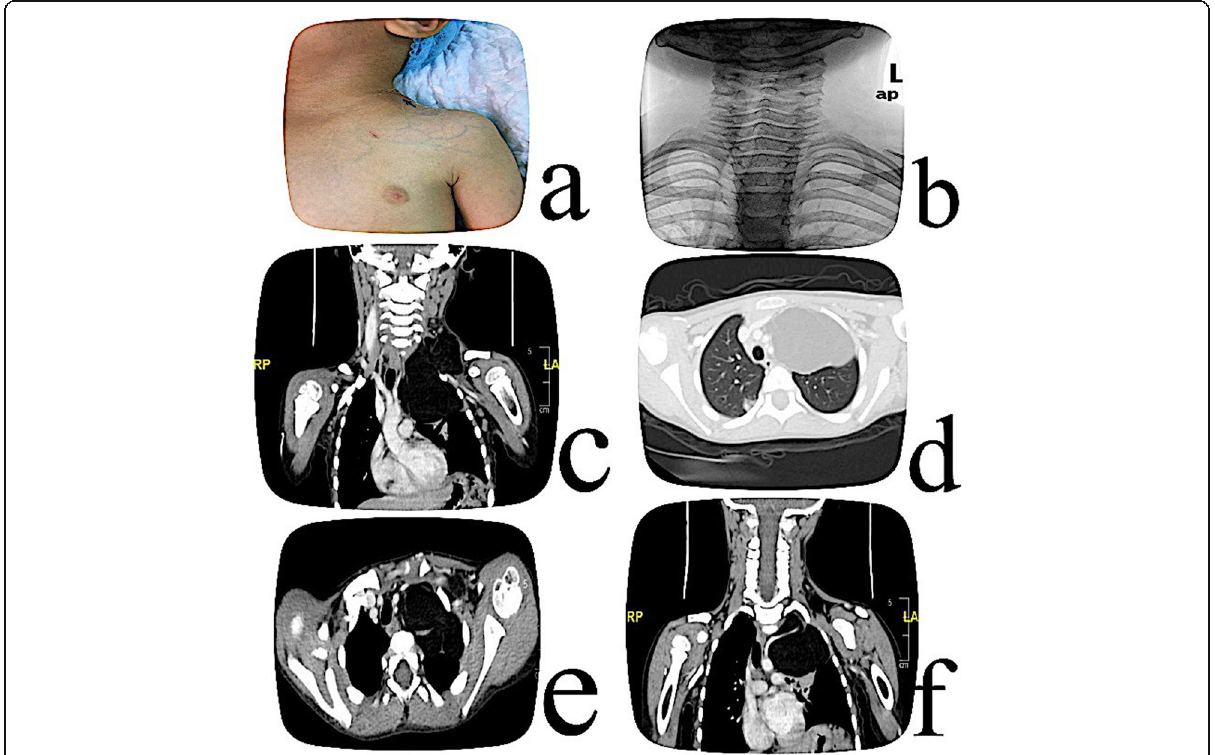
Fig. 1 a Neck mass with dilated superficial veins. b CXR tracheal deviation to the right side. c Lt neck mass with intrathoracic extension measuring about 7×8 cm. d The mass pushed upper mediastinum to the left. e , f The left subclavian artery was encapsulated by the fatty